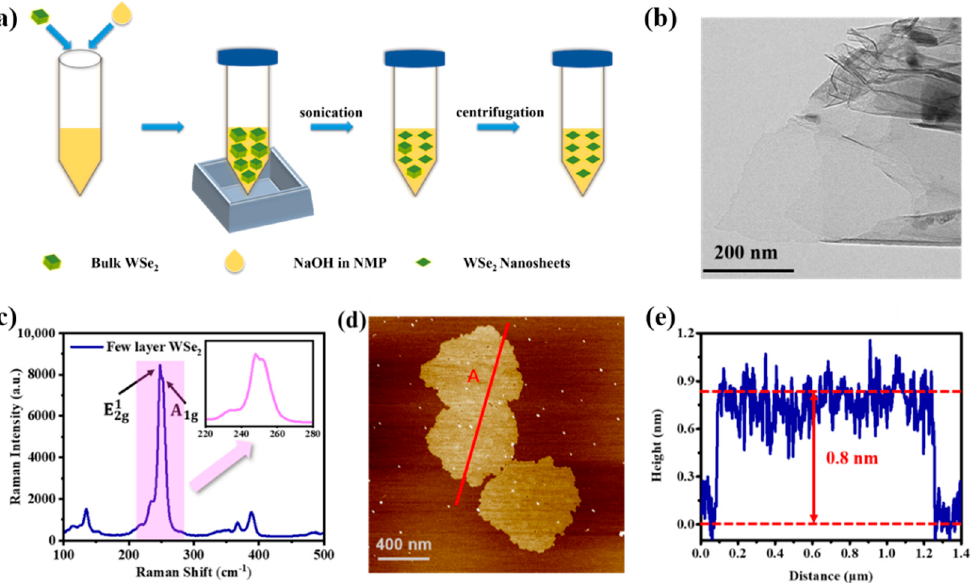
Figure 1. Schematic diagram of fabrication process and characterizations of few-layer WSe 2 nanosheets: ( a ) Schematic diagram of fabrication process of NaOH-LPE. ( b ) TEM images of the WSe 2 nanosheets; ( c ) Raman spectrum of few-layer WSe 2 nanosheet; ( d ) AFM images of few-layer WSe 2 nanosheet; ( e ) height profiles of the section marked in ( d